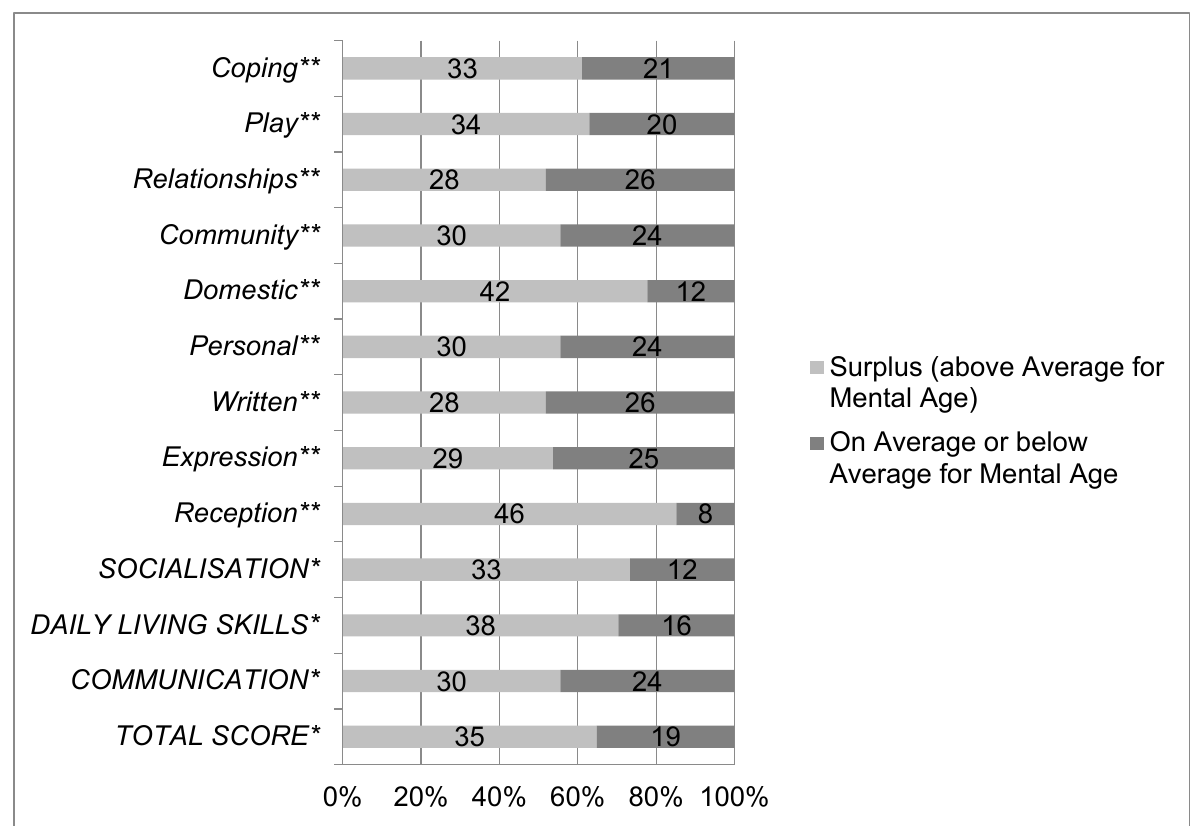
Figure 1. Proportion of individuals with DS ( n = 52) who do (light grey) or do not (dark grey) exhibit a surplus effect on main domains * (communication, daily living skills, socialisation) and subdomains ** of adaptive behaviour (reception, expression, written, personal, domestic, community, relationships, play, and coping) and the adaptive behaviour composite* (total score). * Main domains and total score are written in capital letters. ** Subdomains are written in italic letters.